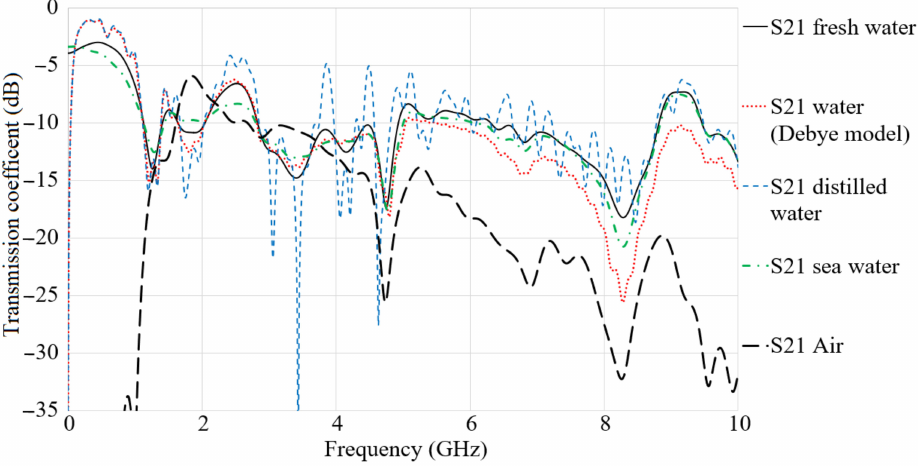
Figure 9. Simulated S 21 results in air, fresh water, water (Debye model), sea water, and distilled